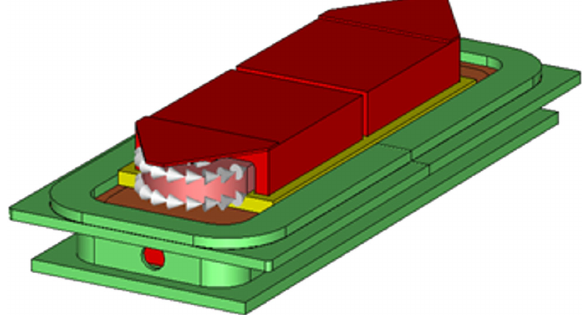
FIG. 15. 3D magnetostatic model of the septum. Additional triangular plates bolted on the magnet at each end add a negative stray field to reduce the total leakage field integral to < 50 μ Tm.